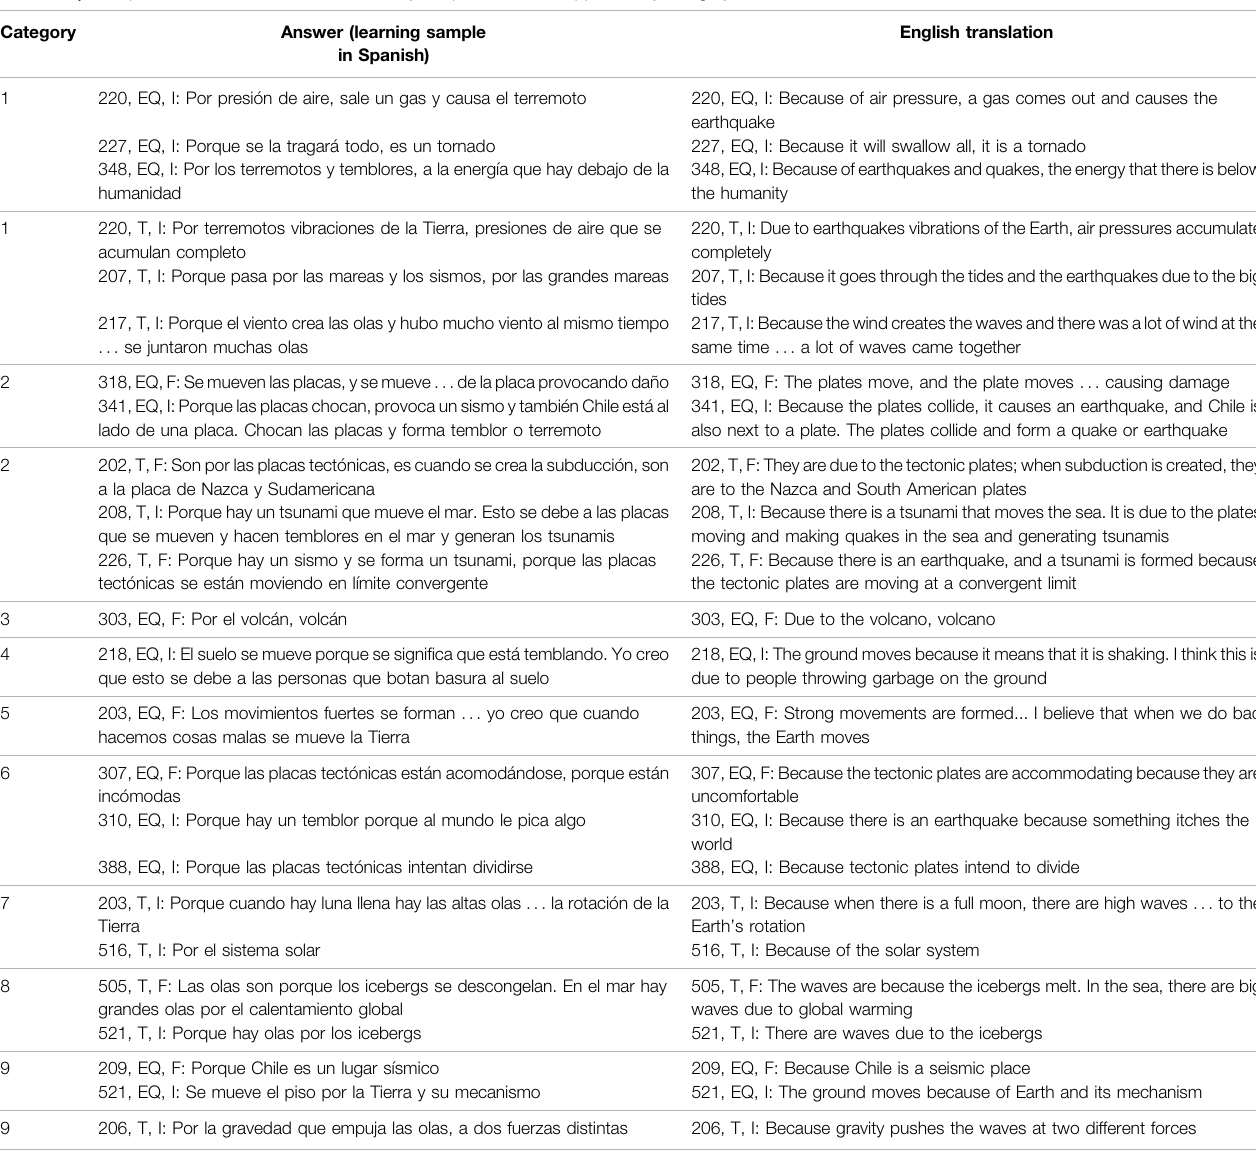
TABLE 1 | Examples of the students ’ answers to “ Why the phenomenon happens? ” by category.